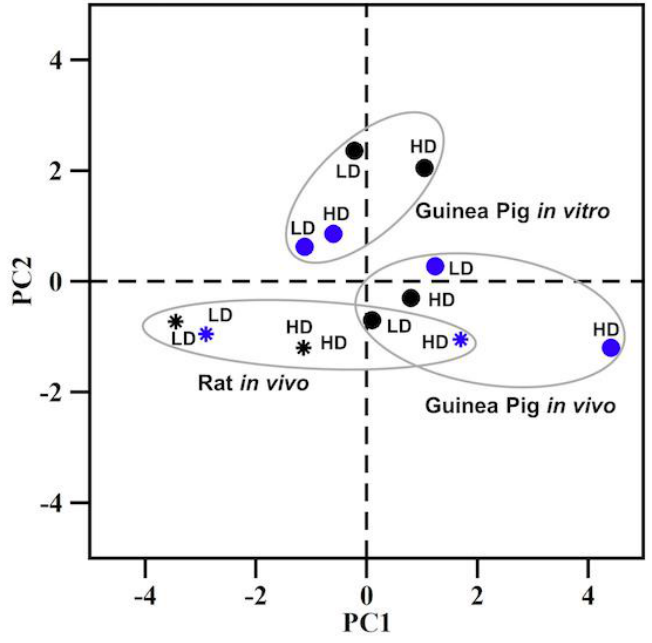
Figure 5. Principal component analysis (PCA) for kidney injury module activation for the different conditions of guinea pig (in vivo and in vitro) and rat data (in vivo) [31]. The circles and asterisks represent samples from guinea pigs and rats, respectively. The black and blue symbols represent the shorter and longer exposure times, respectively. HD, high dose; LD, low dose.